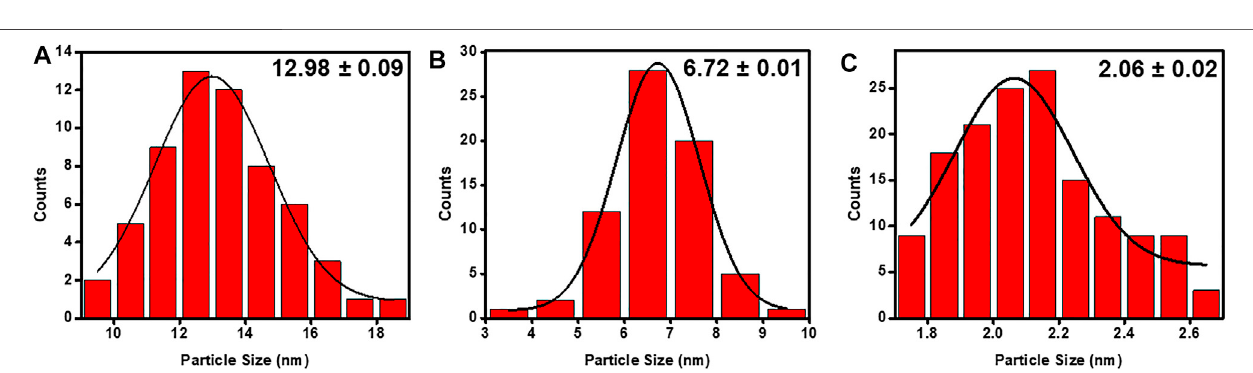
FIGURE 5 | Particle Size distribution graph of (A) Pd NPs, (B) HRG-Pd, and (C) HRG-Py-Pd.